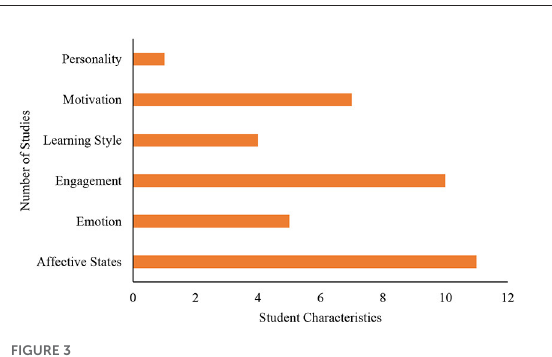
FIGURE3 Trend of student characteristics